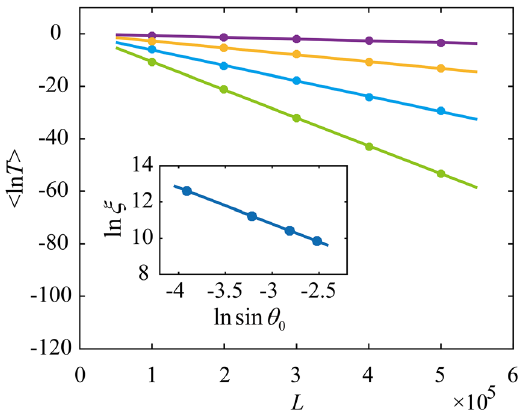
Figure4: (Coloronline)Theensembleaveragedln T N asafunctionof the sample length L for different incident angles for S -polarized waves when α = 1. The purple, yellow, blue and green solid circles denote the numerical results for sin θ 0 = 0.02, 0.04, 0.06 and 0.08, respectively. The solid lines are linear fi ttings. The inset shows the localization length ξ retrieved from the slope of the linear fi tting for different sin θ 0 (solid circles), which are well fi tted by a relation ξ ∝ sin − 2 θ 0 (solid line).